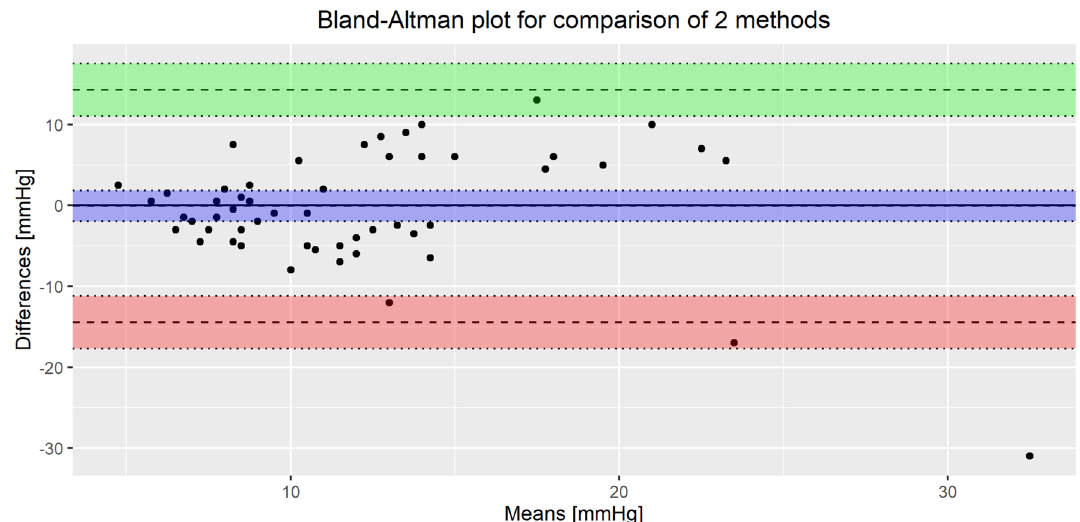
Figure 4. Bland-Altman plot of the agreement between the intravesical and transcutaneous methods of IAP measurement with corresponding 95% confidence intervals of estimates of bias and limits of agreement.